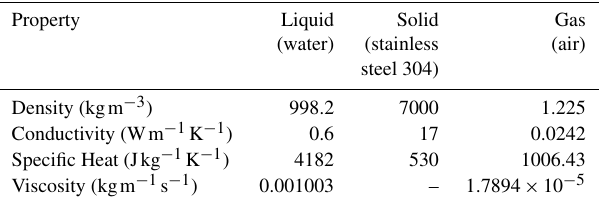
Table 3. The properties for liquid, solid, gas